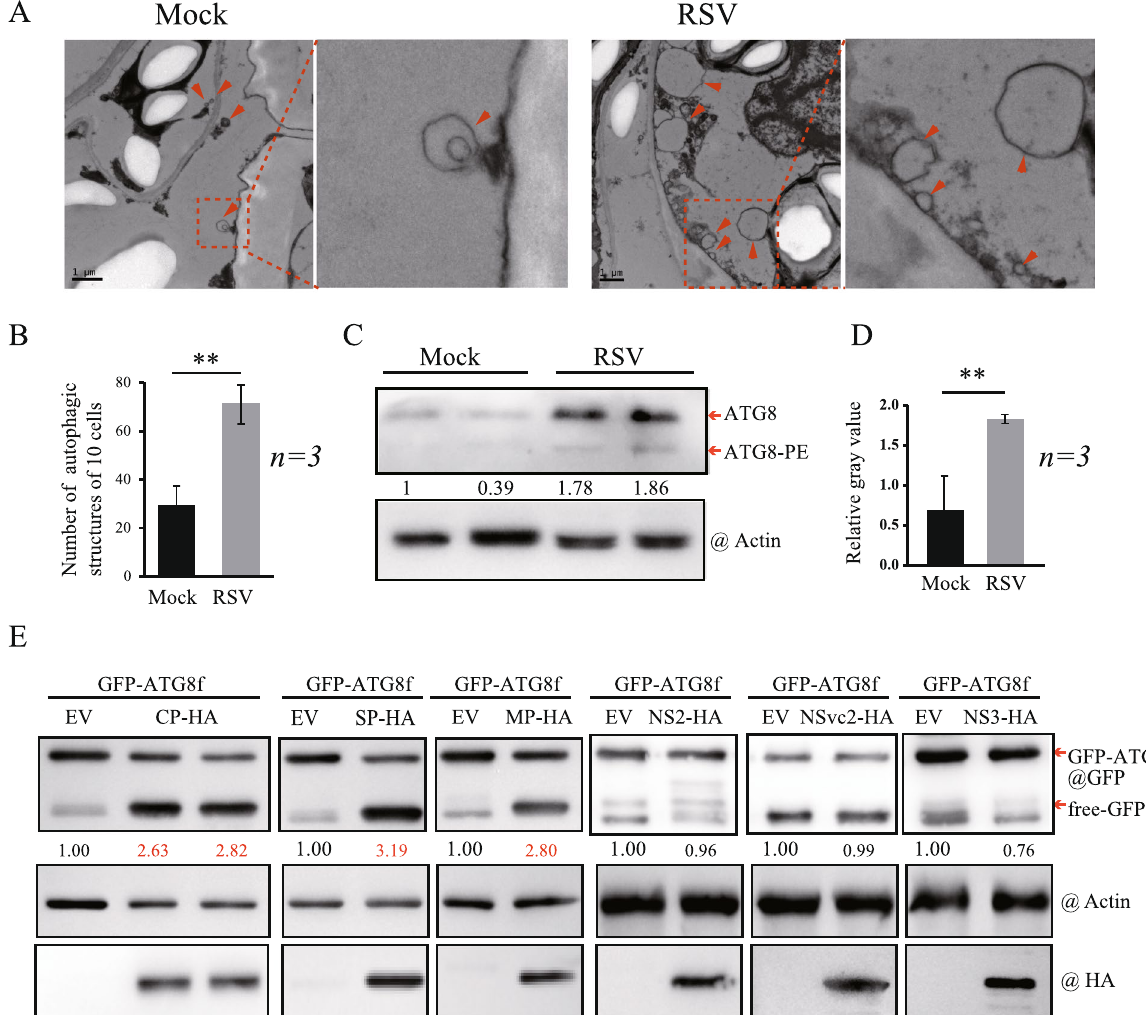
Fig. 1 RSV and RSV coding proteins induce autophagy. A Representative transmission electron microscope (TEM) images of N. benthamiana leaf cells with (right picture) or without (left picture) RSV infection. The ultrastructure of autophagic bodies was observed in the cells (indicated by arrows). B Quantification of the number of autophagosomes in the cells of leaves described in (A). Each bar represents the total number of autophagic bodies from 10 cells obtained from three independent experiments. “**” indicates P < 0.01 (Student’s t -test). C Western blotting analyses of the accumulation of ATG8 and its lipidated form (ATG8-PE) in RSV-infected N. benthamiana plants. Total protein samples were extracted from the upper leaves of plants and subjected to immunoblotting analysis with anti-ATG8 and anti-actin antibodies. D Quantification of the relative autophagic activity in (C). Gray value statistics were normalized to the internal control actin and control plant values, which were set to 1.0. Values represent the standard deviation obtained from three independent experiments. “*” and “**” indicate P < 0.05 and P < 0.01, respectively